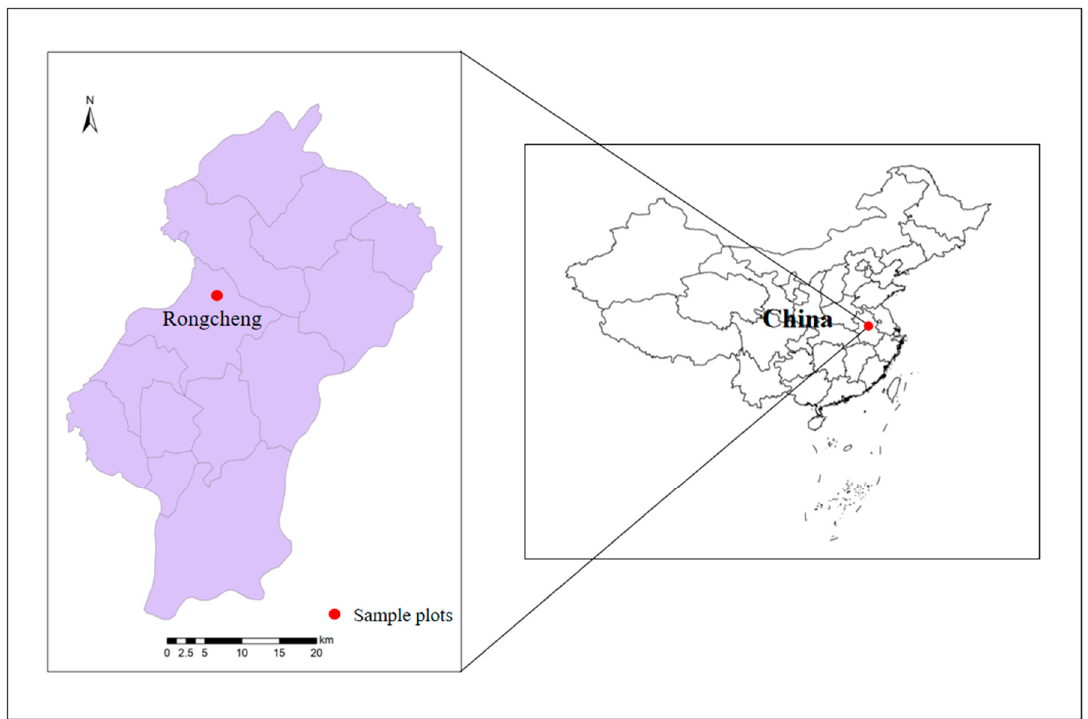
Figure 1. Study area location in Rongcheng Town, Qing yang County, Anhui Province of China.